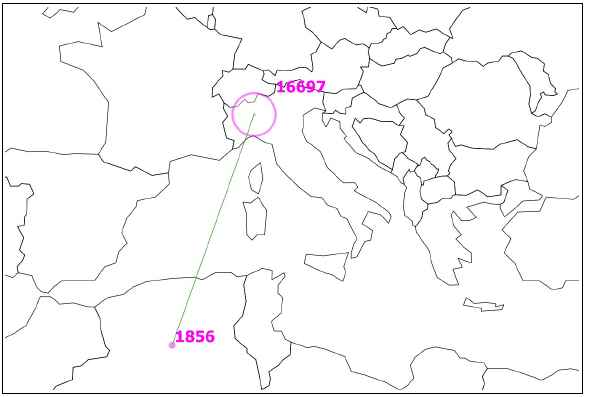
Figure 5. IG of natual gas supply chain for housing heating. The nodes map the amount of non-renewable primary energy used per person in a year. MJ / person * year (Magentino-Abbiatense context)